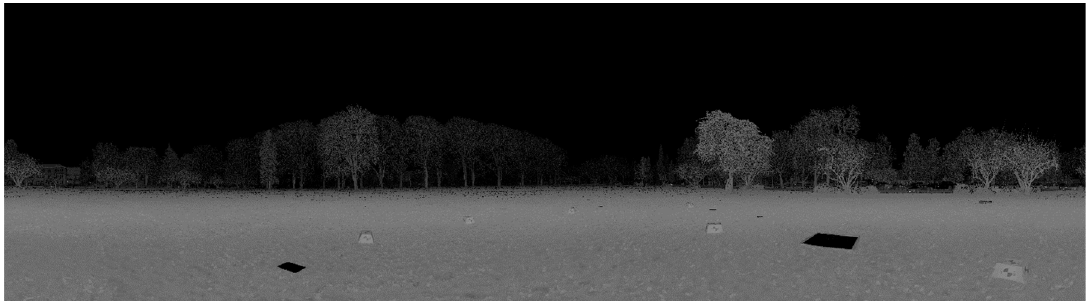
Figure 4. Example of a TLS 2D panoramic image, colored by intensity (grayscale). Black pixels indicate no laser pulse returns and are present in locations with standing water (specular reflection), regions with low reflectivity, and locations beyond the maximum measurement range of the scanner (e.g., the sky and distant horizon).